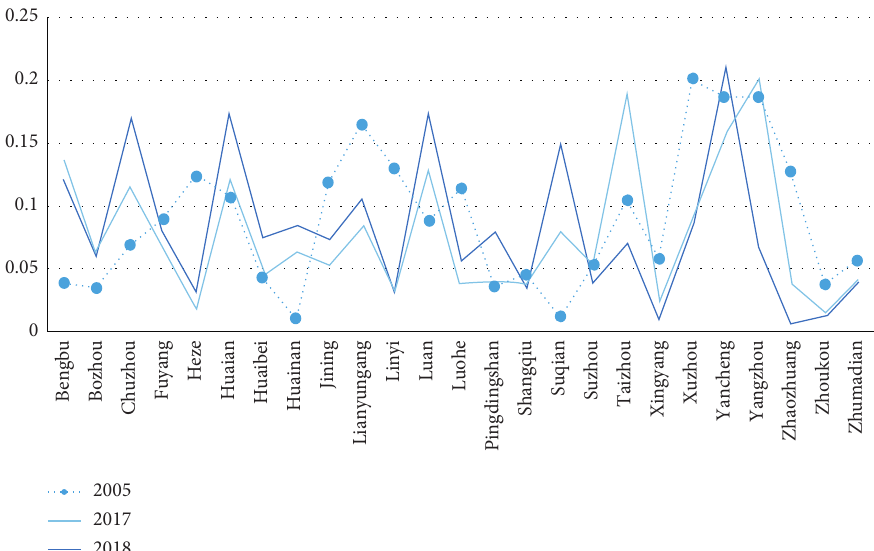
Figure 4: Comparison of innovation efficiency competitiveness among